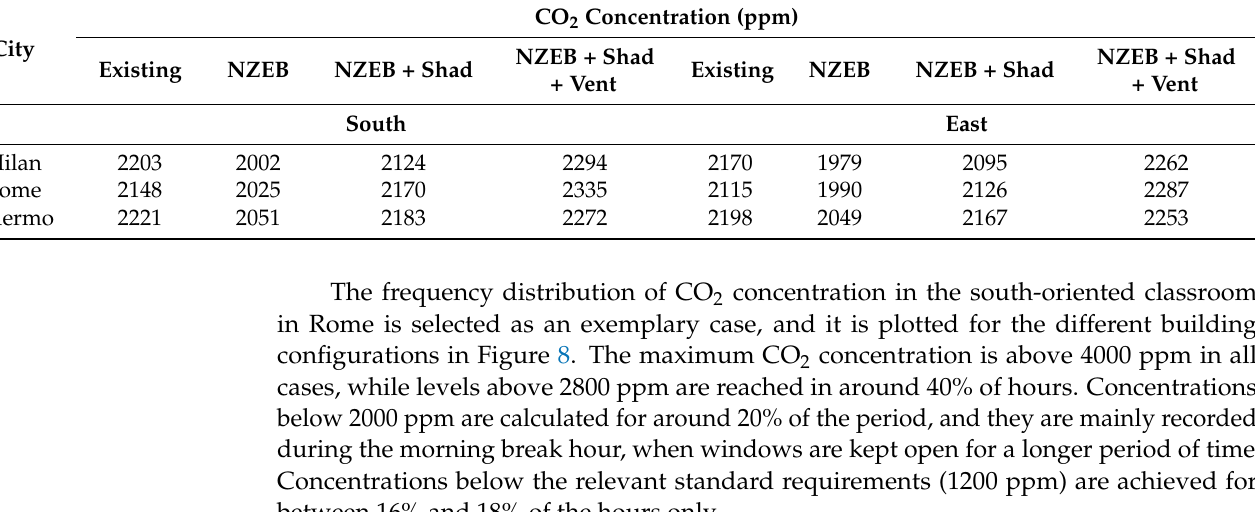
Figure 7. Relative discomfort hours of the different building configurations in Palermo.